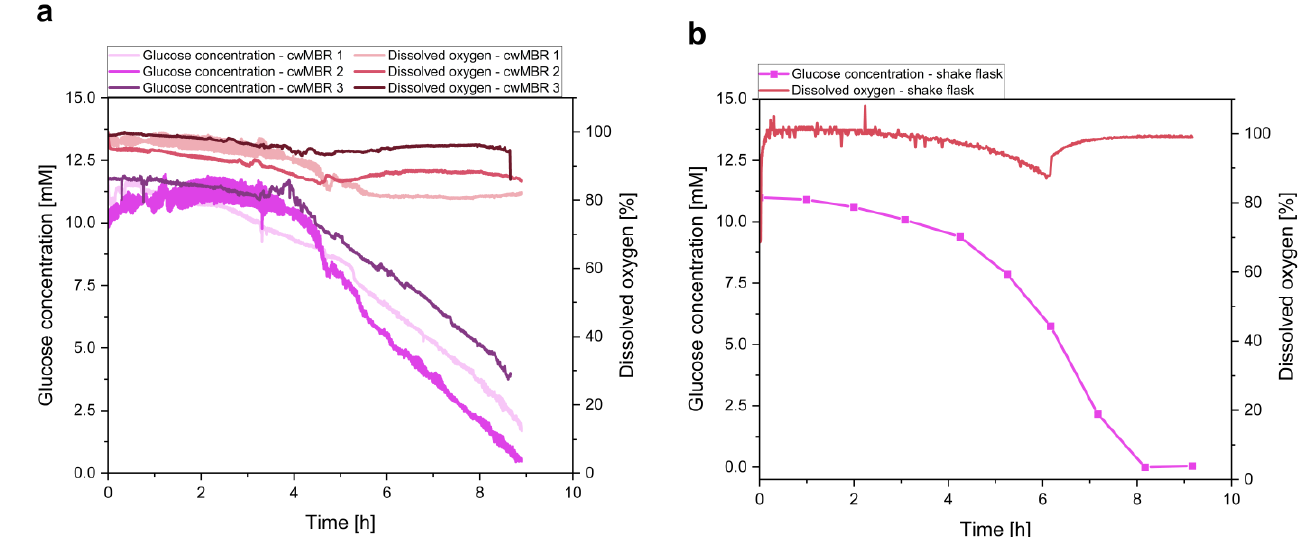
Figure 7. ( a ) Glucose concentration and dissolved oxygen tension of an E. coli cultivation in M9 minimal medium in three parallel cwMBRs, showing consumption of both analytes in all cwMBRs. Vertical oscillation of the cwMBR was performed at 70 Hz and an amplitude of 5%. Both analytes were measured by optical sensors on the bottom of the cwMBR; ( b ) glucose concentration and dissolved oxygen tension of a cultivation of E. coli in shake flasks with M9 medium. The graph shows the mean of triplicates.